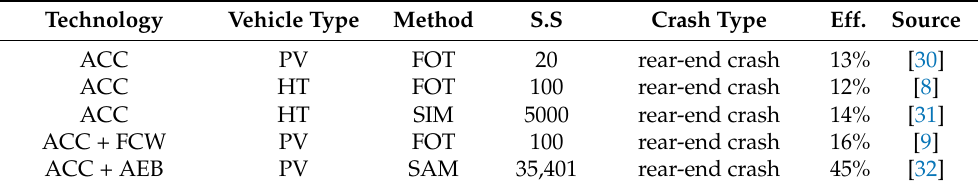
Table 2. Evidence for the crash avoidance effectiveness of ACC.